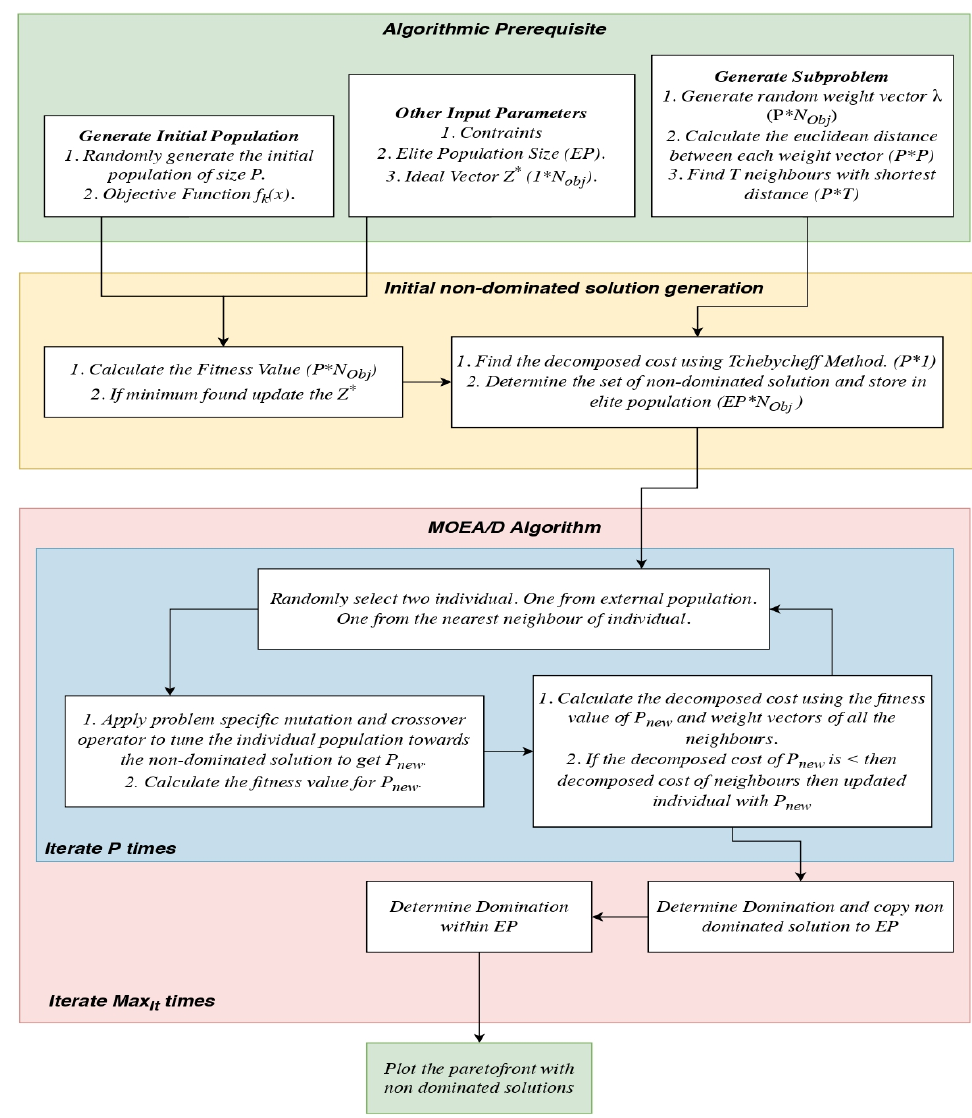
Figure 3. The MOEAD algorithm workflow.